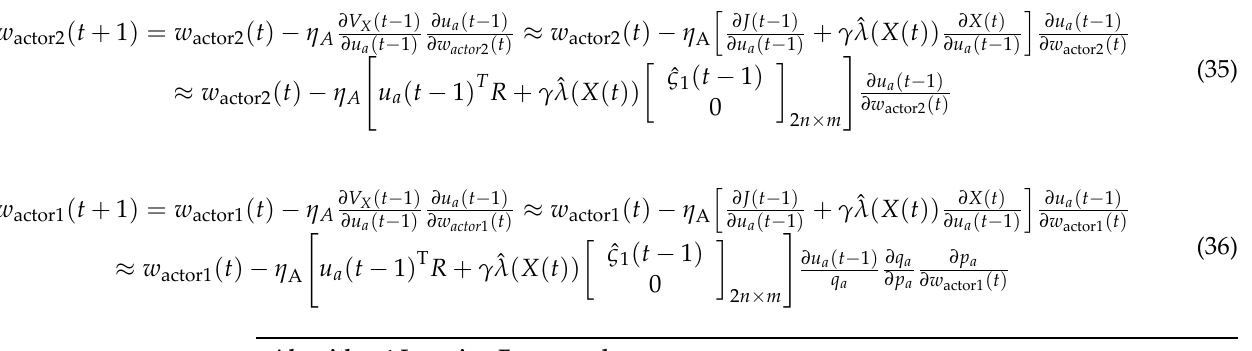
Algorithm 1 Learning